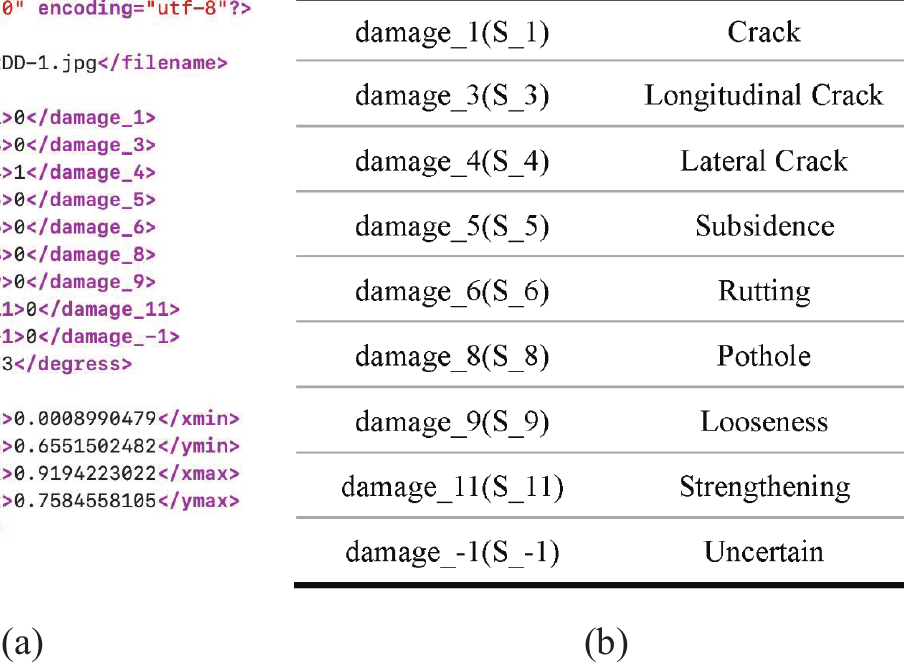
Figure 3. Description of road damage annotation. ( a ) Screenshot of annotation file. ( b ) Correspon- dence between classification codes and damage name.